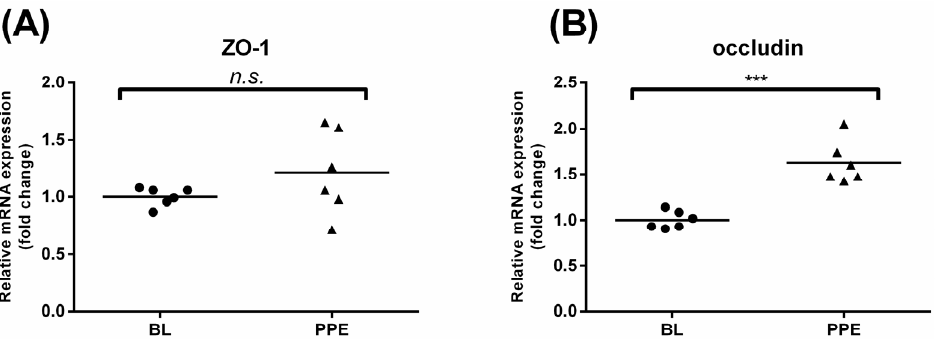
Figure 4. Effects of oral administration of PPE on rat colonic TJ mRNA expression. Distal colon tissues were collected from rats that were administered the control diet or control diet containing PPE (0.3% w/w). Effects of PPE administration on the mRNA expression of ZO-1 and occludin in rat distal colons. ZO-1 ( A ) and occludin ( B ) mRNA expression was analyzed by qRT-PCR. Data are presented as means ± SD ( n = 6). *** p < 0.001, n.s., not significant.